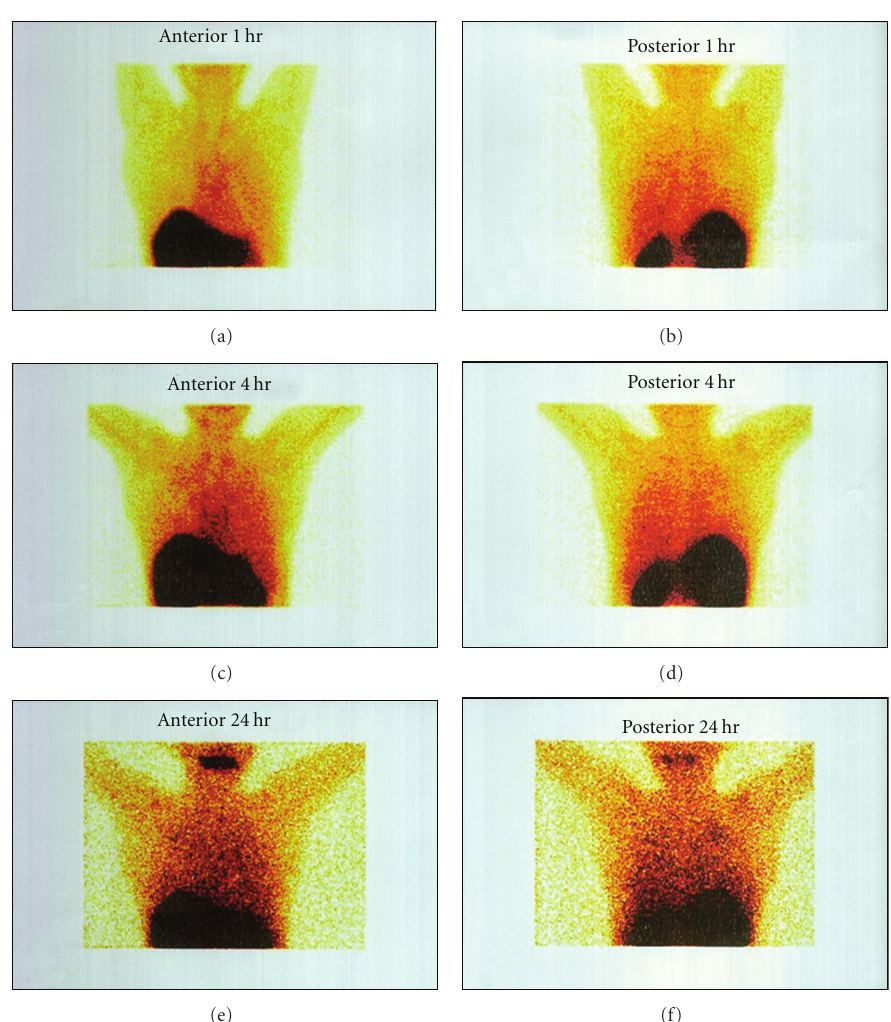
Figure 5: Scintigrams of human showing preferential localization of radiotracer in the resistant lung lesion after 1, 4, and 24 hours postinjection of 370 MBq of 99m